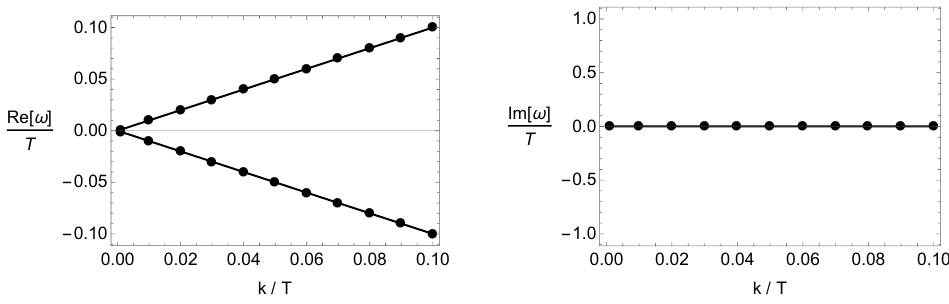
Figure 14 . The emergent propagating photon at zero density, zero magnetic field and zero EM coupling λ/T = 0